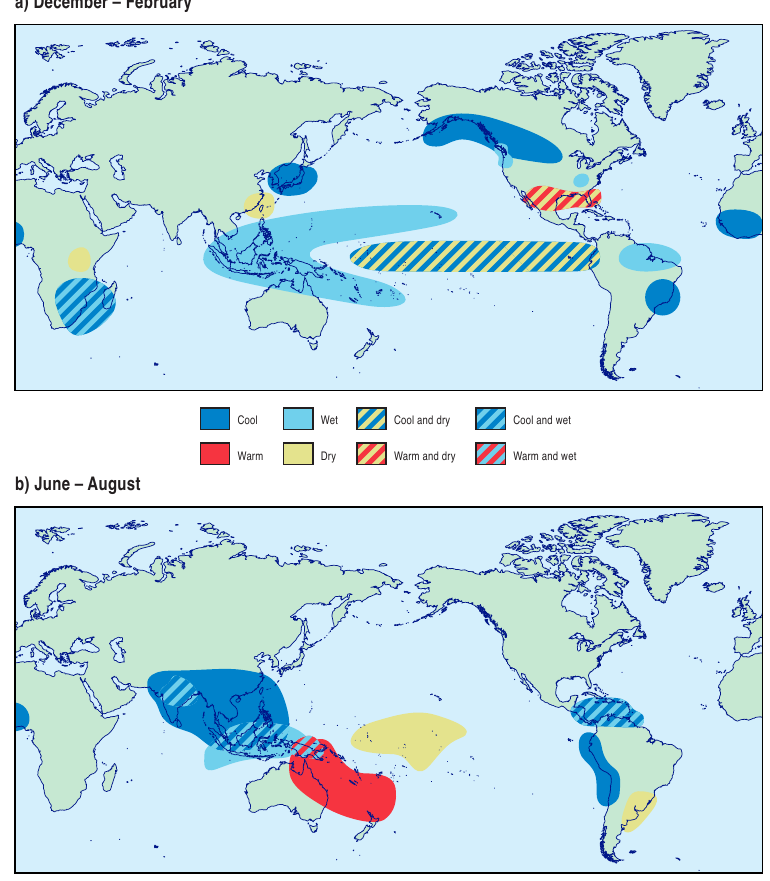
Figure 8. Canonical climate impact patterns of La Niña for ( a ) December–February and ( b ) June–August. Sourced and redrawn from the Climate Predicition Centre http://www.cpc.ncep.noaa.gov/products/ analysis_monitoring/ensostuff/ensofaq.shtml#GLOBALimpacts.